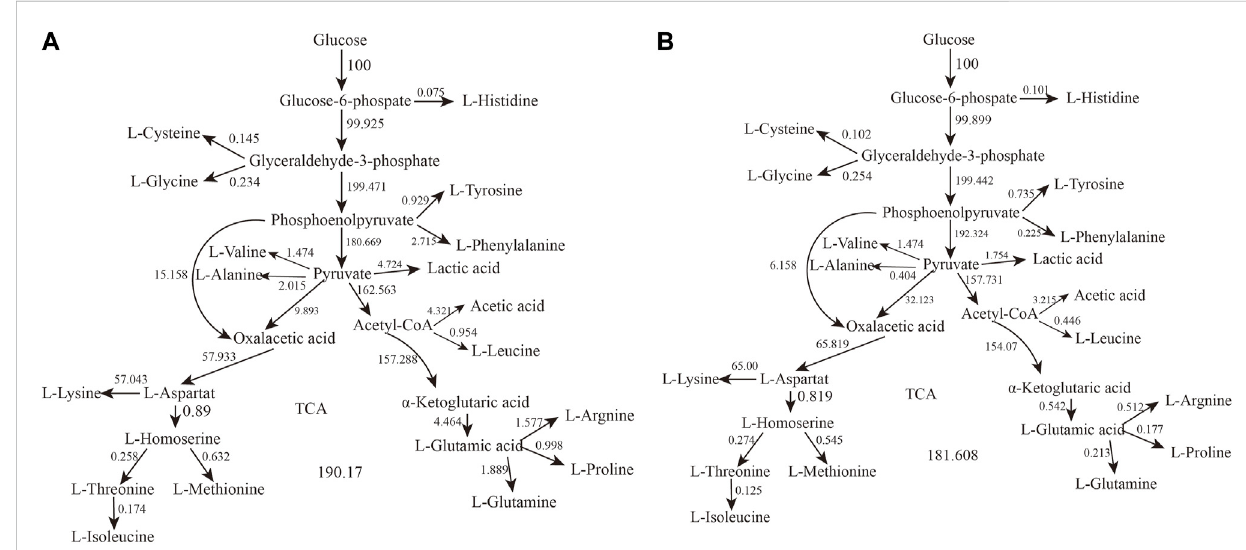
FIGURE 5 Metabolic network calculation results. (A) Metabolic fl ow in conventional bioreactors. (B) Metabolic fl ow in oxygenated